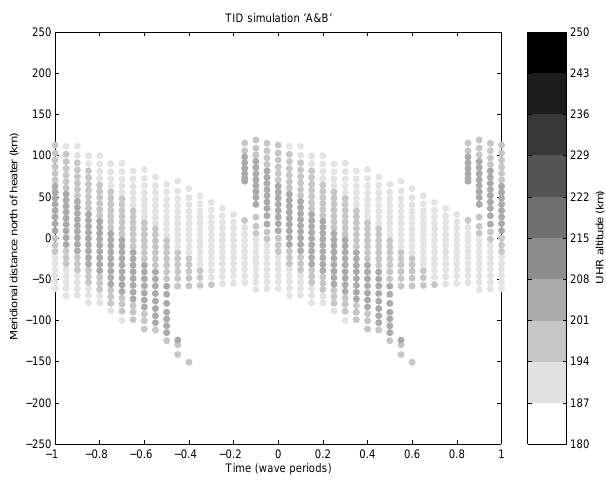
Fig. 5. As Fig. 4 but for perturbations “A” and